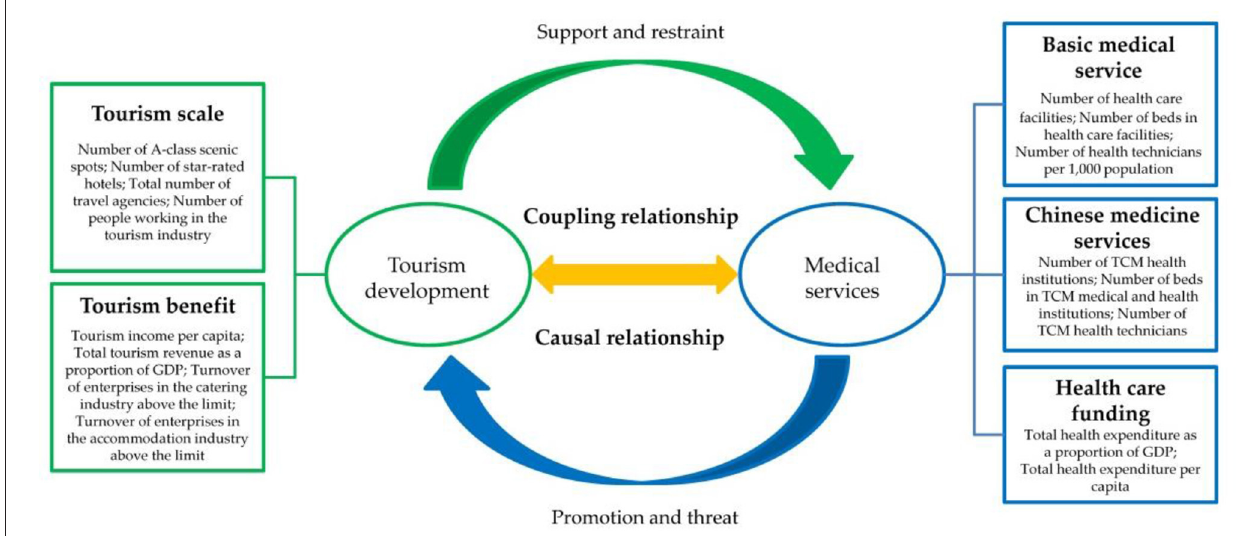
FIGURE 1 | Conceptual framework for the relationship between tourism development and medical services.